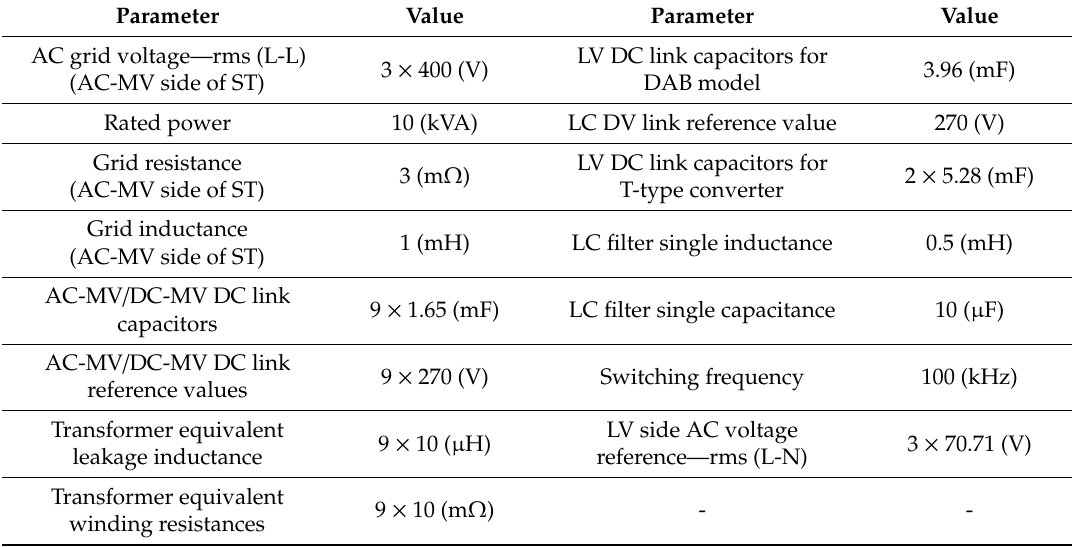
Table 2. The ST simulation model